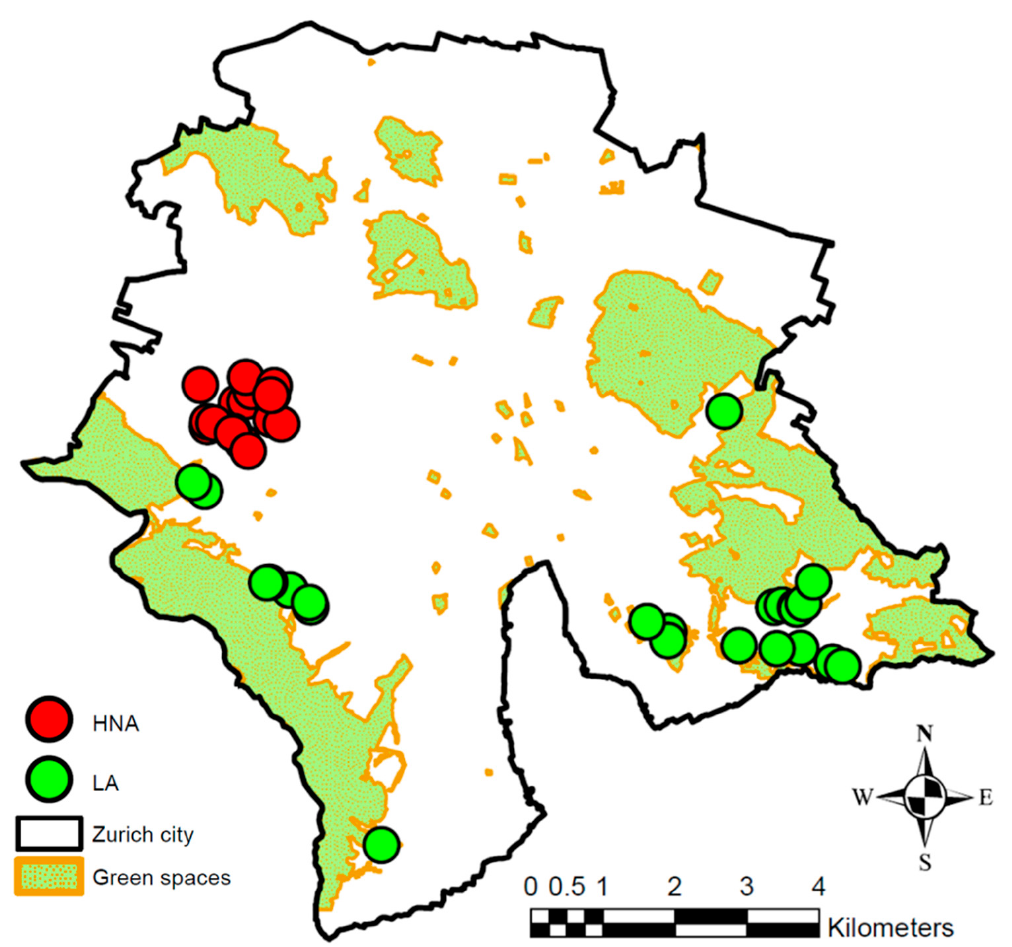
Figure 8. Pilot study locations of the participants’ residences buildings in subgroups HNA ( High noise exposure at home with No access to GSs , in red) and LA ( Low noise exposure at home with access to GSs ”, in green) and GSs included in the study. The participants’ locations are approximate for data privacy purposes.